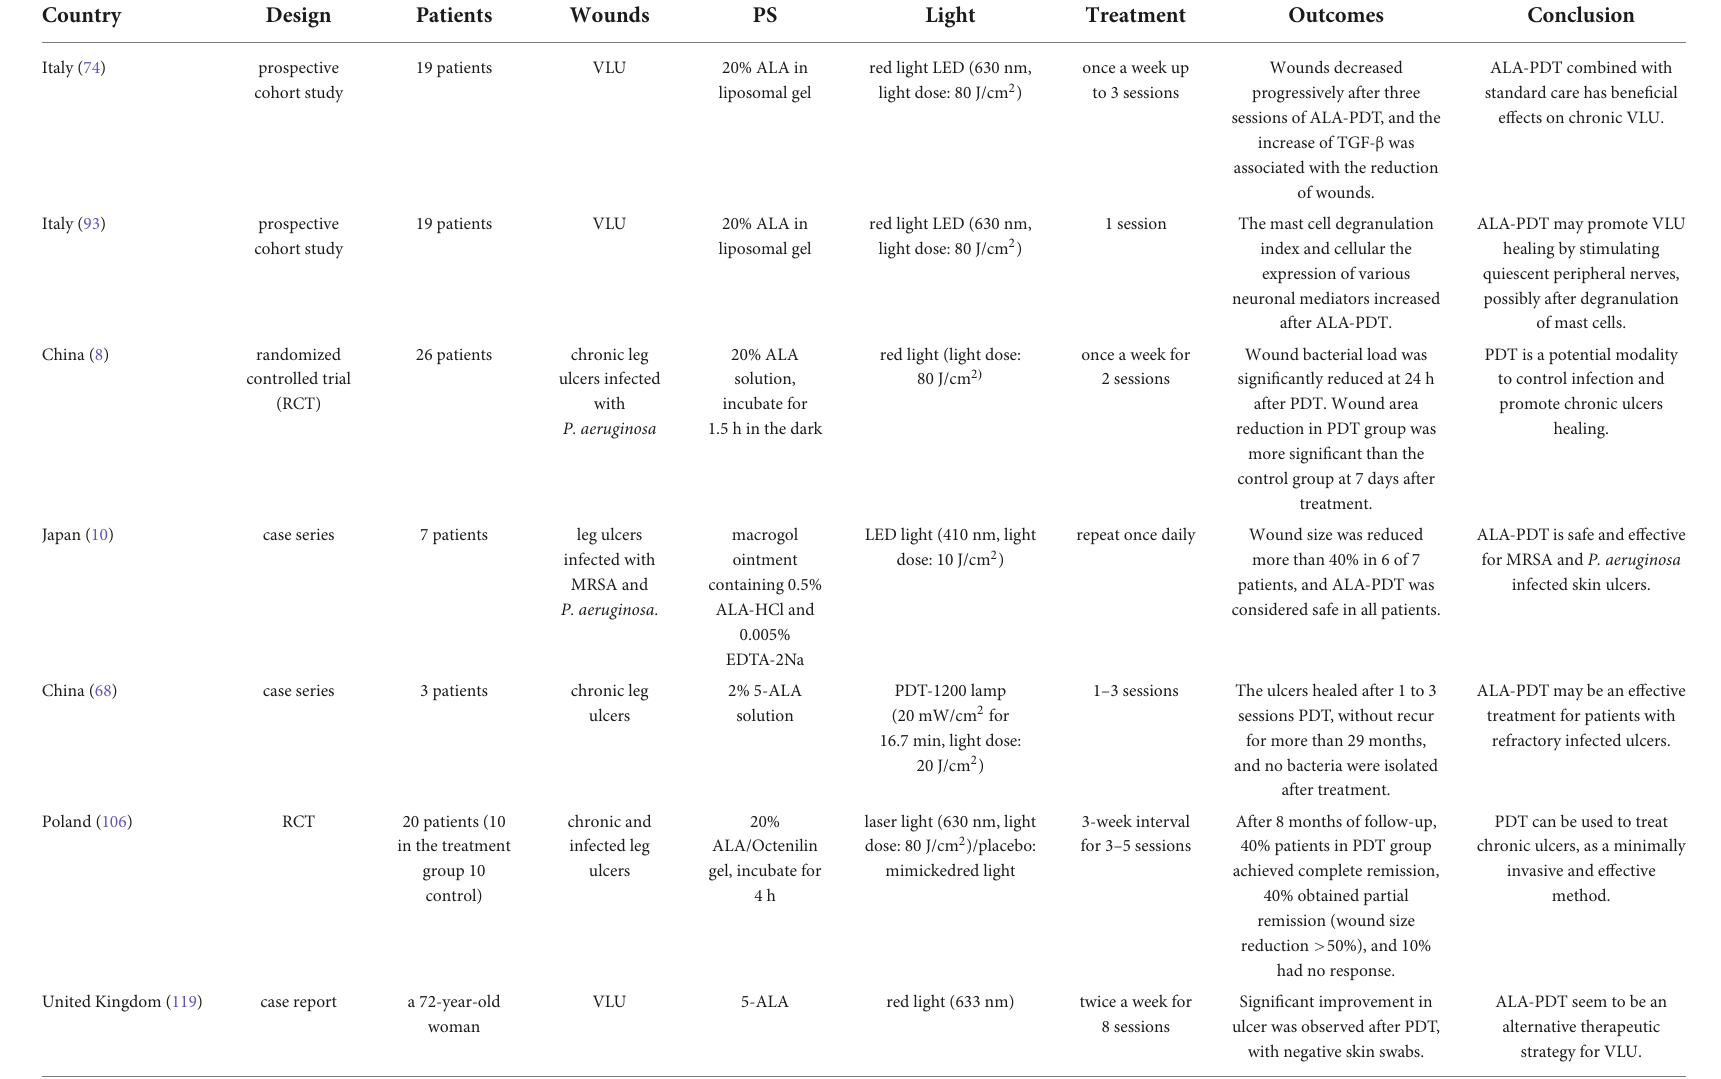
TABLE 1 Clinical studies involving PDT in chronic leg ulcers.